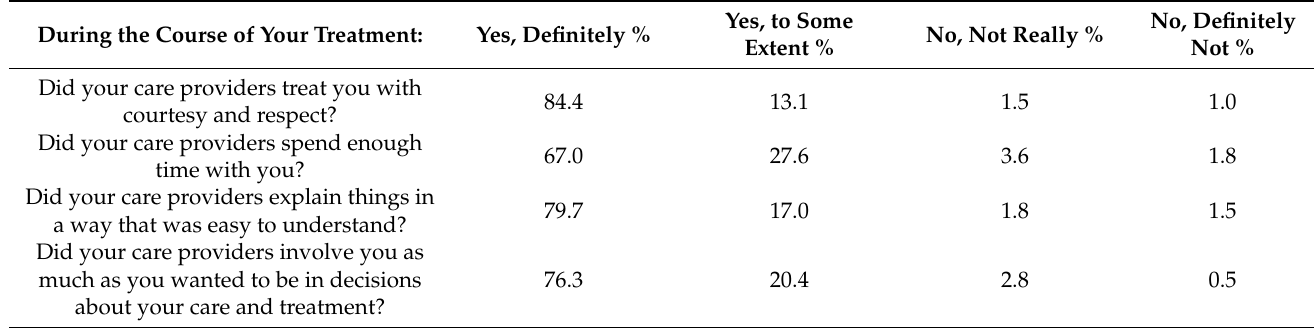
Table 2. Frequency in relation to treatment